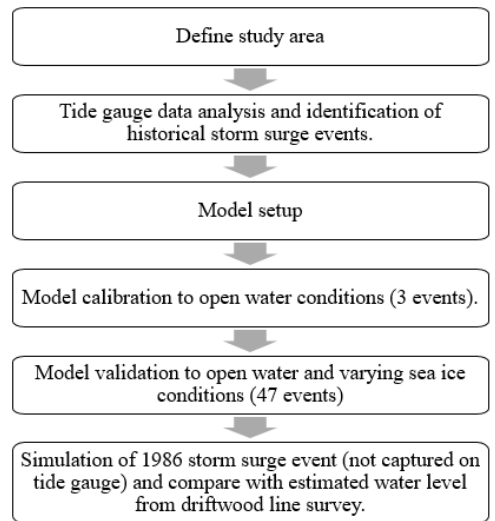
Figure 1. Overview of the study methodology.